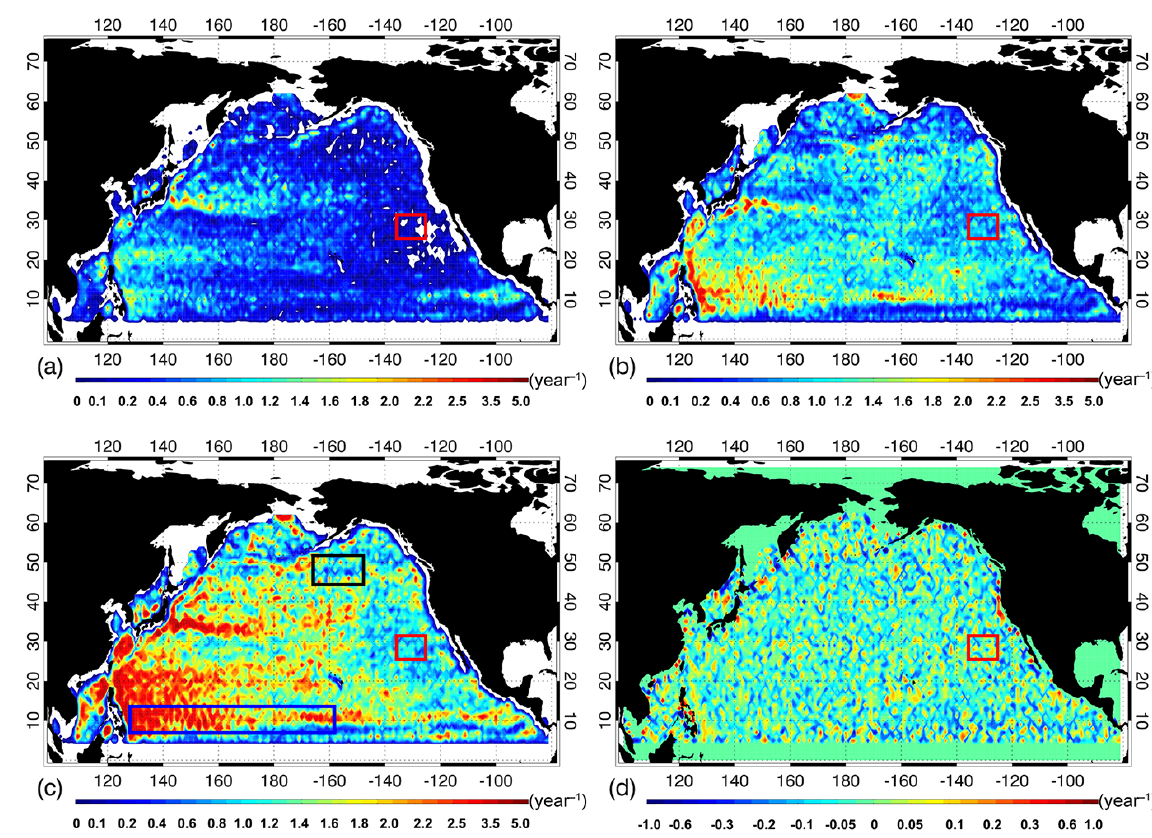
Figure 12. The frequencies of dynamic processes per 1 ◦ × 1 ◦ grid element. (a) The merging frequency for cyclonic eddies. (b) The merging frequency for anticyclonic eddies. (c) The merging frequency for all eddies. (d) The ratios of the difference between the frequencies of merging and splitting for all eddies to the sum of merging and splitting frequencies for all eddies. The boxes are the same as in Fig. 9. The blue box is the location of NEC, where the merging frequency is